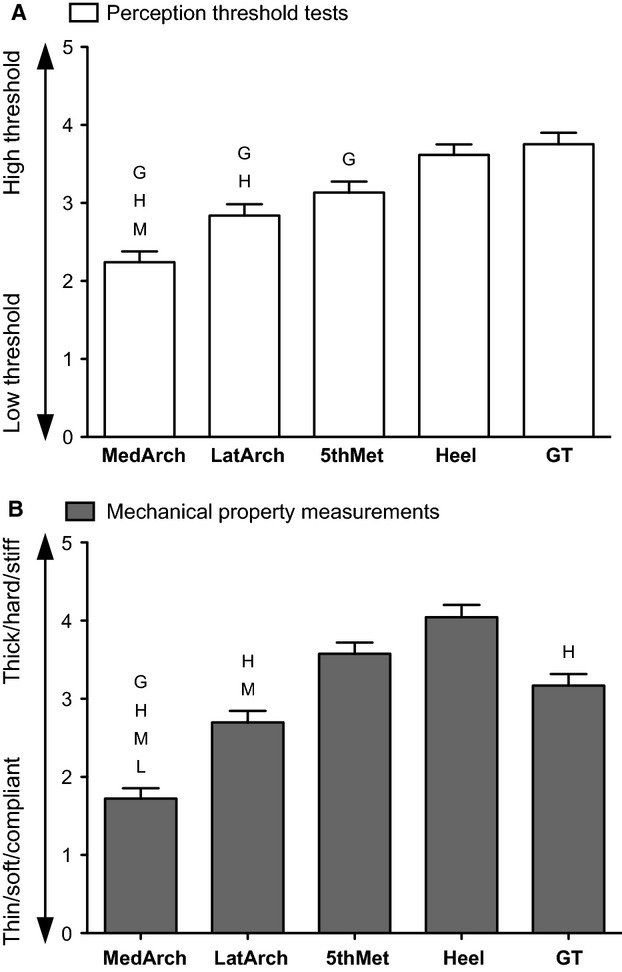
Foot sole sites ranked by perceptual threshold (A) and mechanical properties (B). For each subject, a rank of 1 was given to the site with the lowest, and a rank of 5 to the site with the highest perceptual threshold or mechanical property measurement. Ranks were averaged across subejects for each foot sole site. Error bars represent the standard error of the mean. L, M, H and G denotes a significantly lower ranking of that site than the LatArch, 5th Met, Heel, and GT, respectively (P < 0.05).